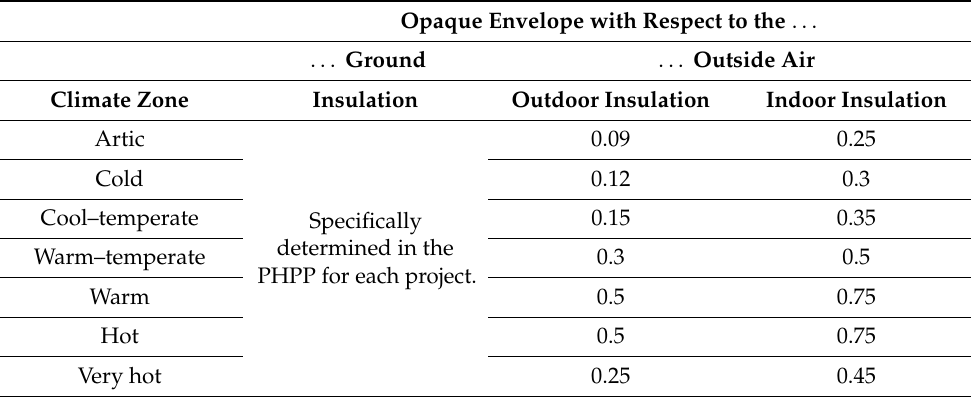
Table 4. Thermal transmittance (W/m 2 K) according to Passive House Institute [19]. Opaque Envelope with Respect to the...